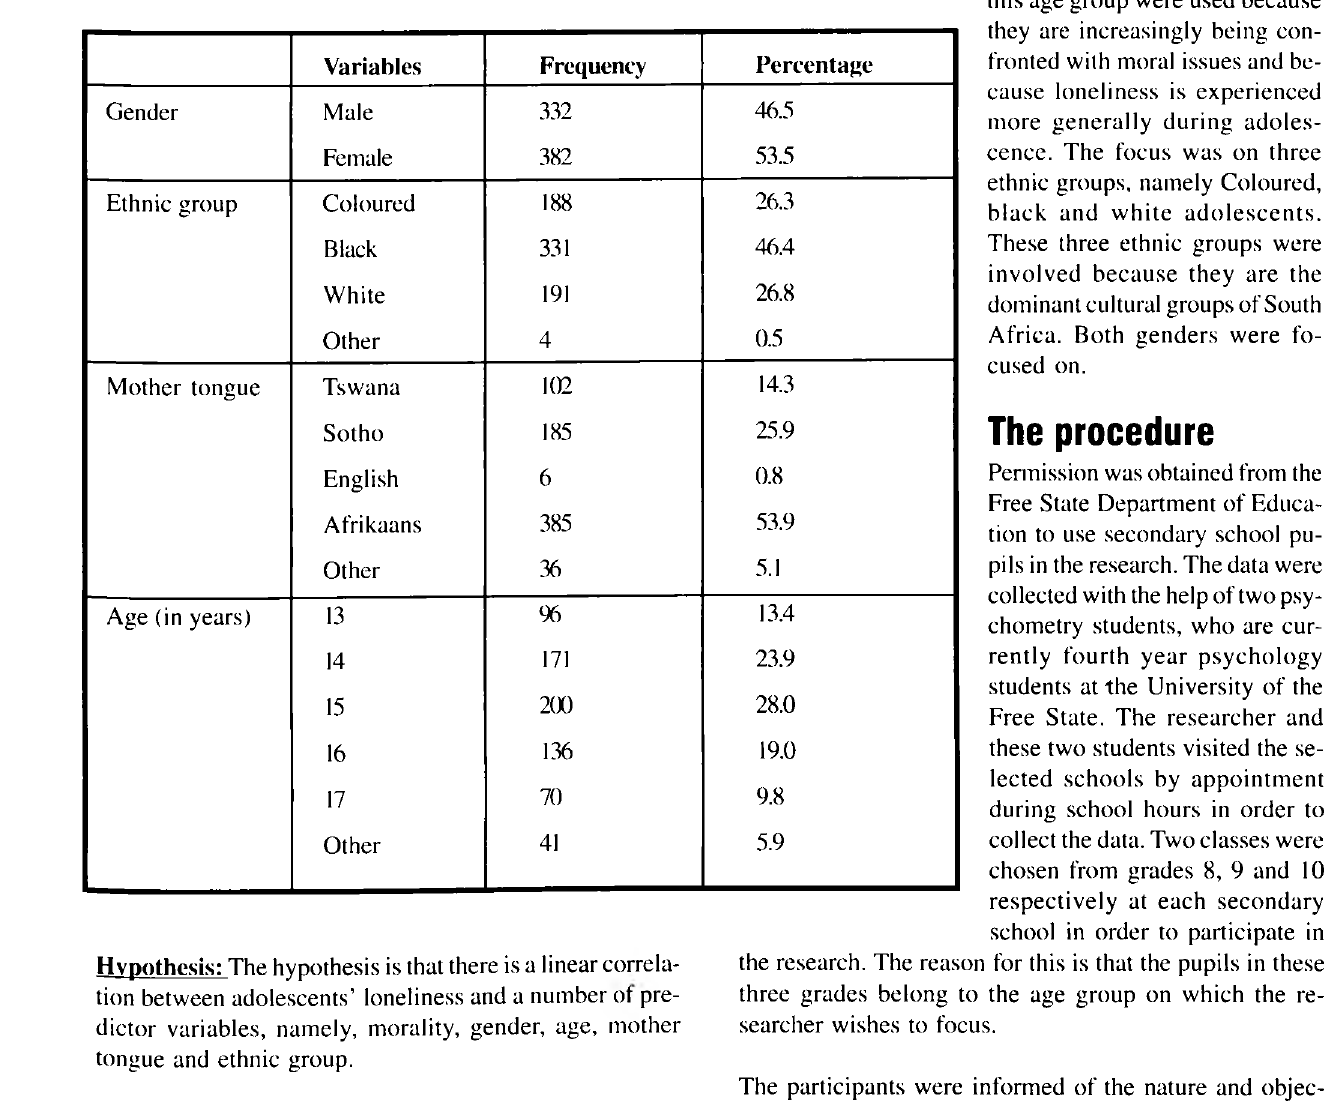
TAB LE 1 : Frequency and percentages of all the predictor